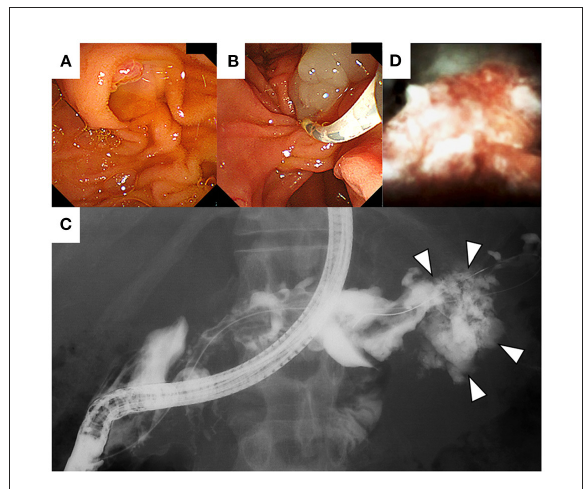
FIGURE5 On endoscopic retrograde cholangiopancreatography (ERCP), the papillae shows a fish-mouth appearance (A) . After ERCP catheter insertion into the main pancreatic duct, extrusion of mucus from the pancreatic orifice of the papillae was observed (B) . Contrast injection shows the correlation between the main pancreatic duct and the mass at the pancreatic tail (C). Per-oral pancreatoscopy showing an irregular-shaped solid mass in the pancreatic tail (D) .